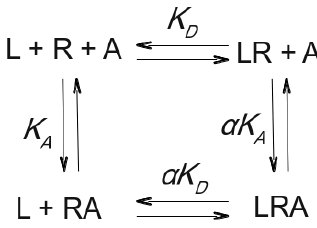
Figure 1. An orthosteric ligand L binds to the receptor R with equilibrium dissociation constant K D , and an allosteric modulator A binds to the receptor R with an equilibrium dissociation constant K A . The orthosteric ligand L and the allosteric modulator A can bind concurrently to the receptor R to form a ternary complex LRA. Binding of one ligand to the receptor changes the equilibrium dissociation constant of the other ligand by a factor of cooperativity α [15].